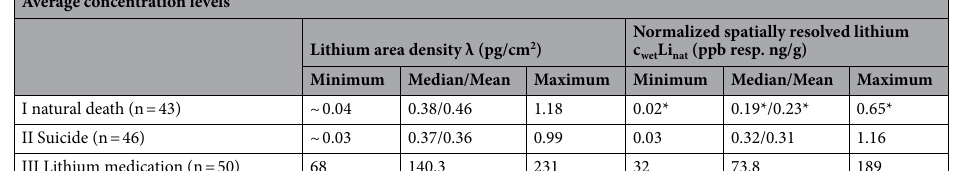
Average concentration